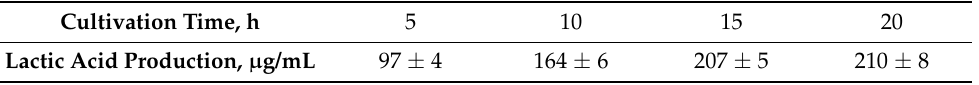
Table 8. Dynamics of lactic production in the process of LF3872 strain cultivation in the MRS broth. Cultivation Time, h